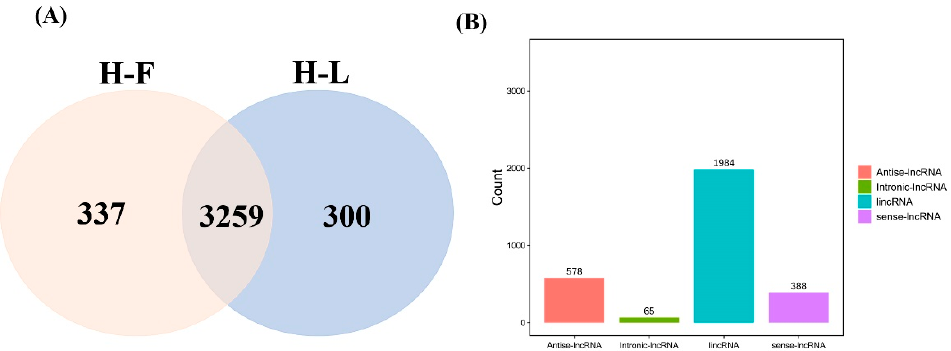
Figure 1. LncRNA identification and classification in the pituitary gland. ( A ) The lncRNAs were identified by two prediction software programs, CNCI and CPC. ( B ) The number statistics of different types of lncRNAs.